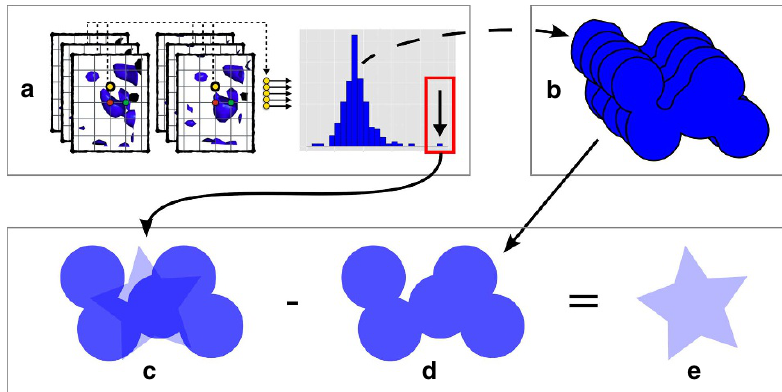
Figure 1 | Schematic of how outlier identification and background subtraction reveals changed-state density. ( a ) Analysis of the aligned electron density distribution for the same voxel (yellow dots) identifies data sets which differ from the ensemble—outliers—such as those containing a bound ligand or other ‘changed state’, for example the changed state in c . ( b ) Averaging over multiple ‘ground-state’ data sets further provides an accurate estimate of the ground-state density, leading to d . With pixel intensity representing electron density strength, ( c ) shows an identified location, at which the density is a superposition of changed-state (20%) and ground-state (80%) densities; the changed state is obscured by the superposed ground state. ( d ) shows only the ground-state density, adjusted by applying a weighting (BDC ¼ 0.8). ( e ) The density that remains after subtracting the background yields an estimate of the changed state which is in general fully interpretable.